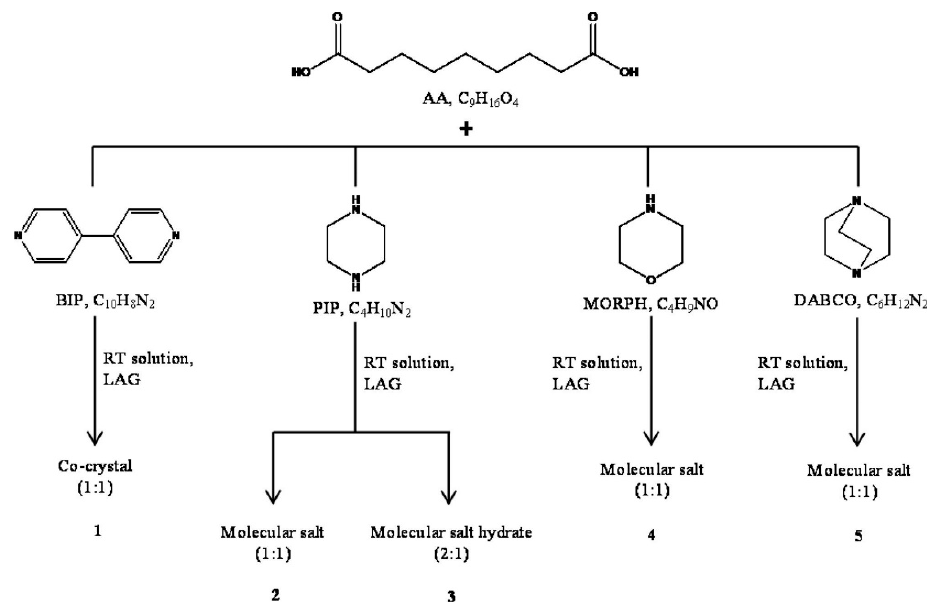
Figure 10. Experimental conditions and products obtained in the reactions between AA and BIP, PIP, MORPH, and DABCO [64].